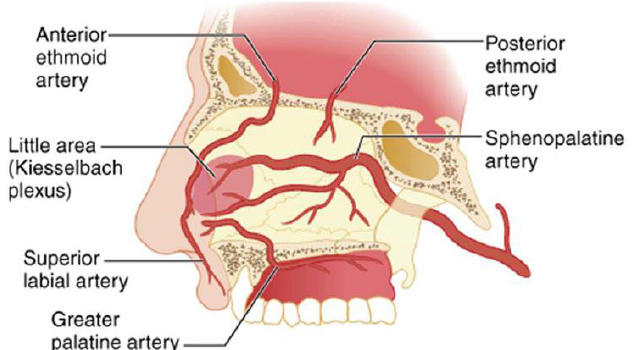
Figure 2: Vascular supply of the nose (Source: Tintinalli